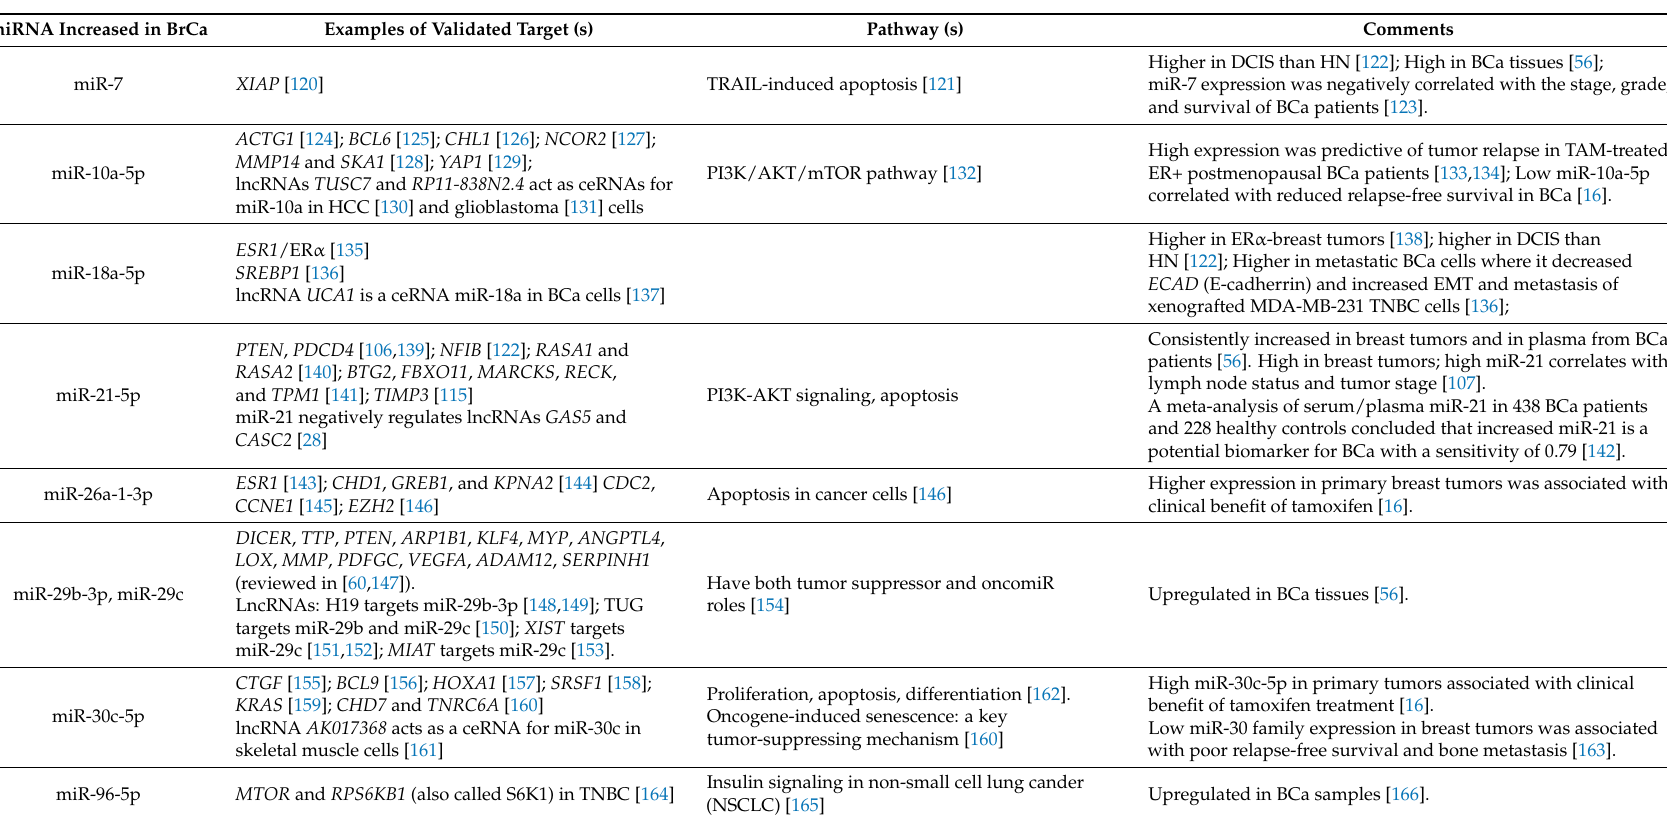
Table 2. Examples of miRNAs upregulated in breast tumors, patient plasma, and breast cancer cell lines with their authenticated targets. miRTarBase was used to identify validated targets [119], i.e., those not identified by reference number. Abbreviations: AI = aromatase inhibitors, BCa = breast cancer; ceRNA =